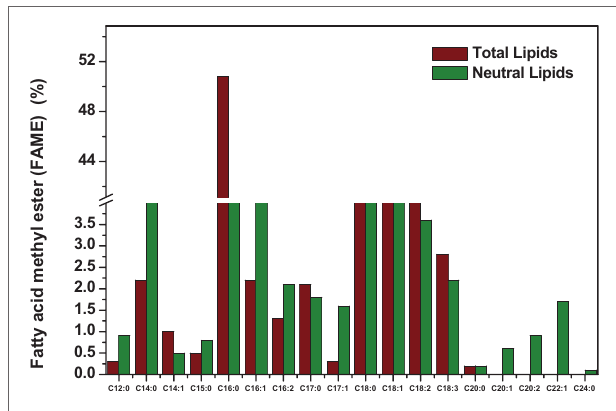
FigUre 2 | Fatty acid methyl ester (FaMe) composition of experimental condition six (Tl) and eighth (nl) .